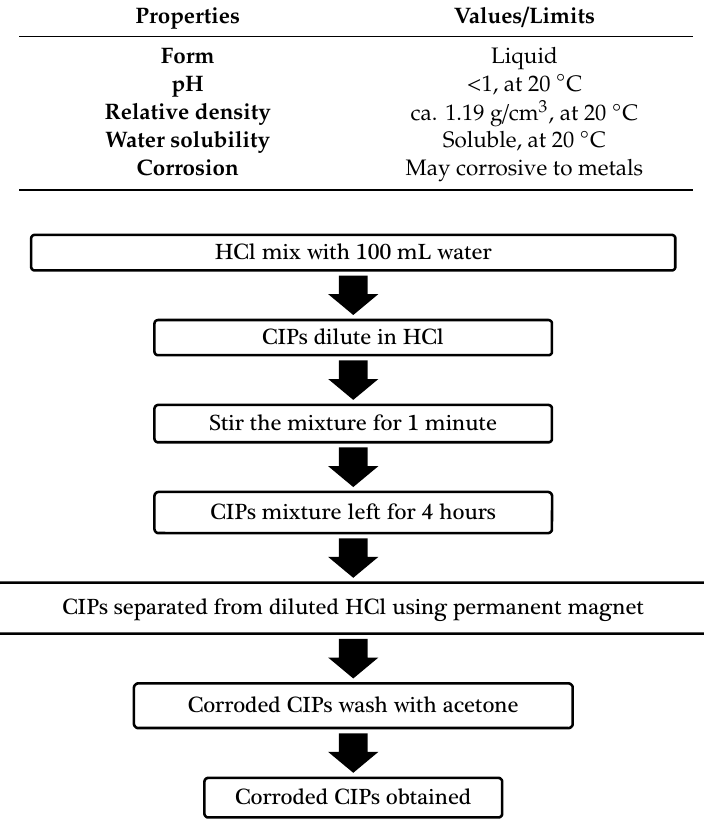
Table 6. Basic properties of hydrochloric acid grade AR.